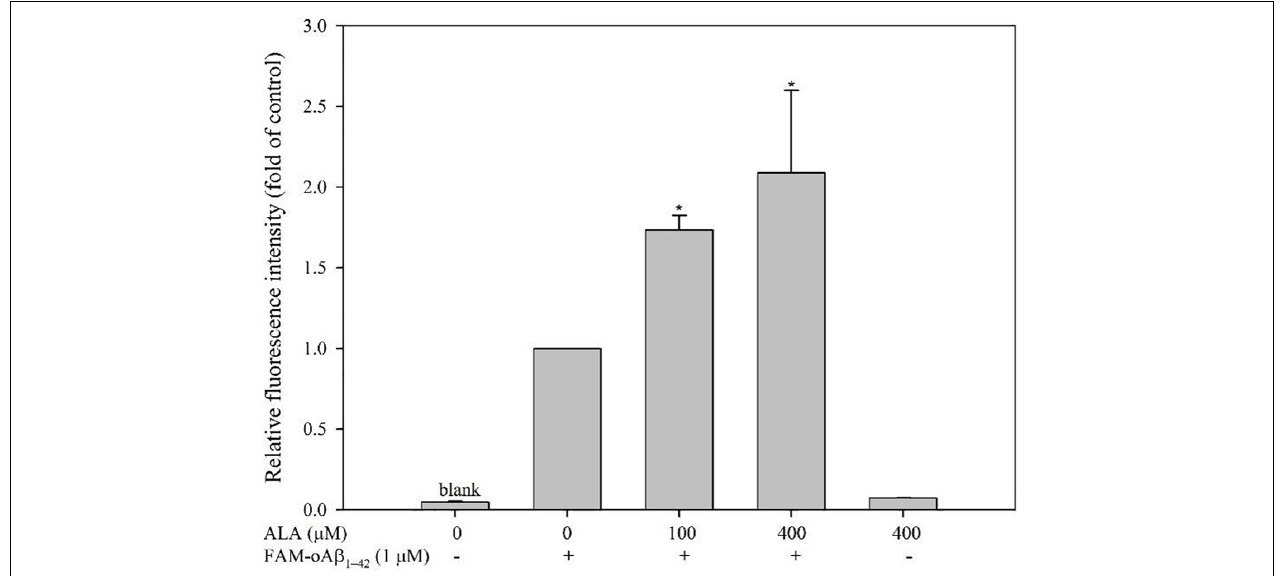
FIGURE 2 | Effect of alpha-lipoic acid (ALA) on 5(6)-carboxyfluorescein (FAM)-oligomeric A β (oA β 1 − 42 ) uptake in BV-2 mouse microglial cells. BV-2 cells were pretreated with or without ALA (100 or 400 µ M) for 30 min, followed by FAM-oA β 1 − 42 treatment for 24 h. Mean fluorescence intensity was detected using a flow cytometer. * p < 0.05 vs. the FAM-oA β 1 − 42 group.